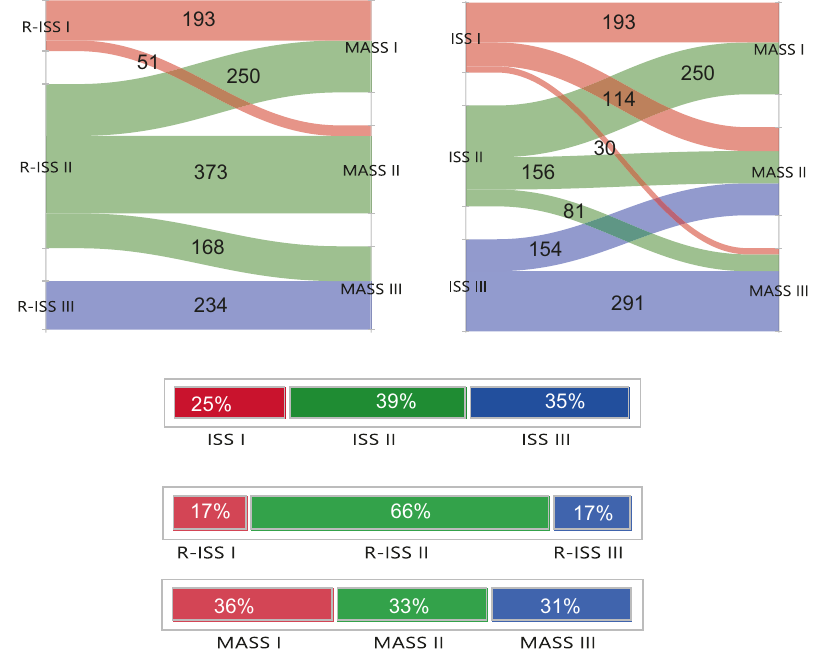
Fig. 5 Stage migration between R-ISS and MASS and ISS and MASS. The distribution and migration of patients between disease stages using ISS, R-ISS, and MASS risk strati fi cation systems. ISS International Staging System, R-ISS Revised International Staging System, MASS Mayo Additive Staging System.